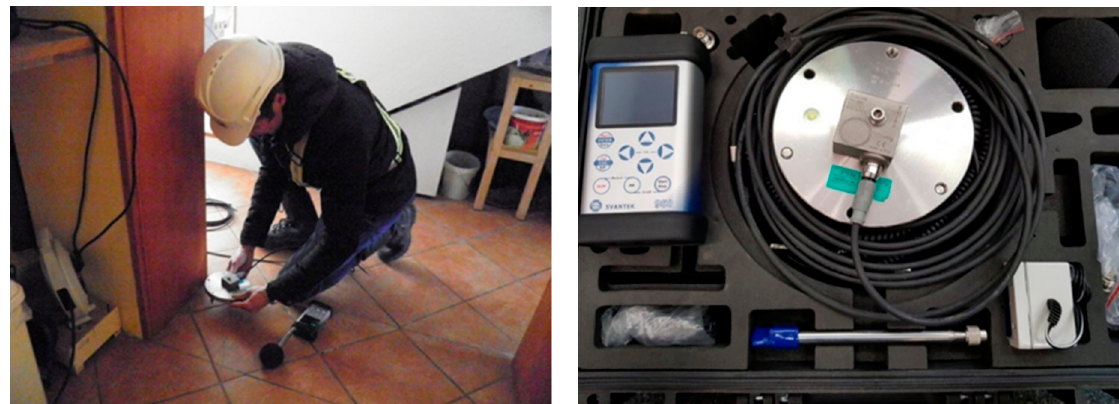
Figure 5. Placement of the vibrograph Svantek 958 A-Position S2 (source: author).